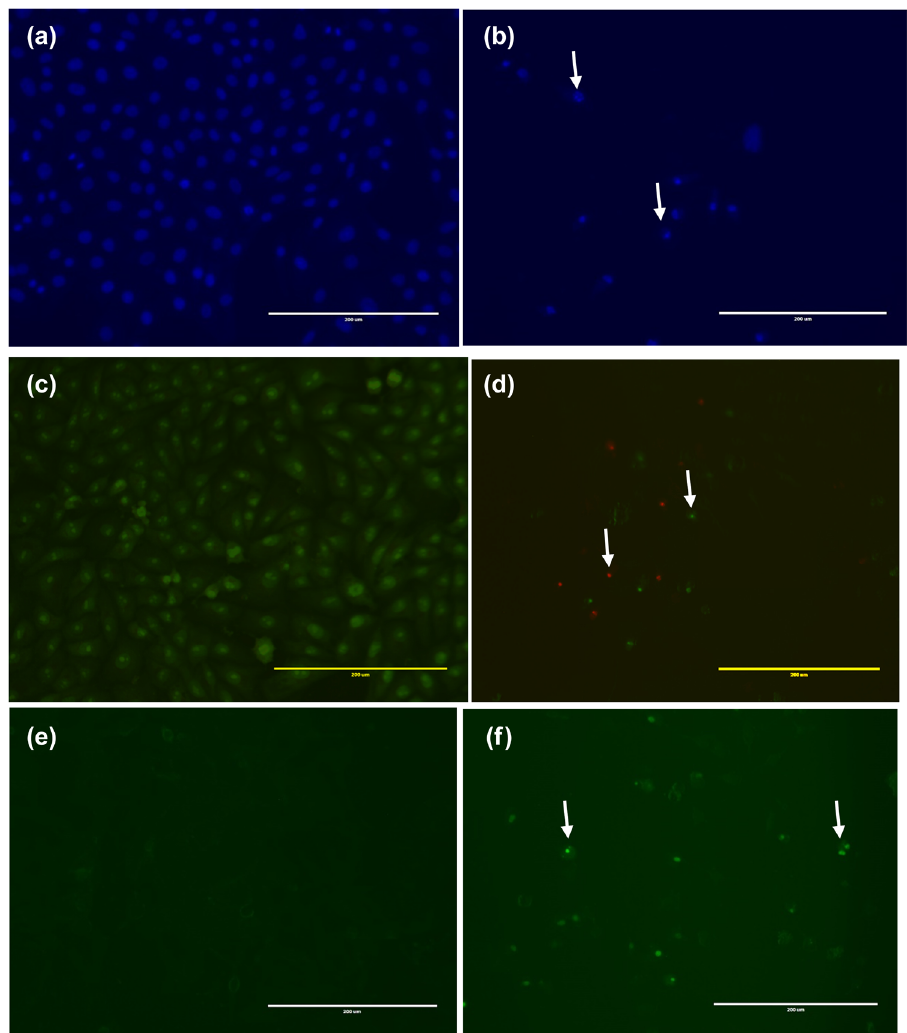
Figure 5: Fluorescence image of MCF - 7 cells treated with DAPI, AO/EB, or caspase - 3/7 regent after 24 h of treatment with 5d . DAPI staining shows chromatin condensation and nuclear fragmentation as indicated with arrows: ( a ) untreated cells and ( b ) treated cells. AO/EB staining: ( c ) untreated cells and ( d ) treated cells. Live cells are stained evenly green, whereas apoptotic cells are characterized by shiny green and yellow - orange staining due to loss of membrane integrity and chromatin condensation. Caspase - 3/7 activation: ( e ) untreated cells and ( f ) treated cells. Caspase - 3/7 activation was demonstrated by green fl uorescence. Magni fi cation ×